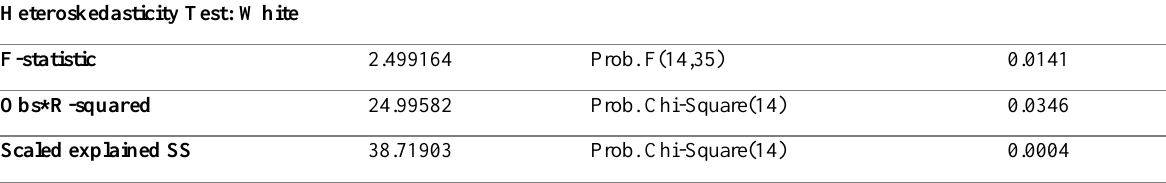
Table 4: Results of the Repair Heteroscedasticity Test with Logarithms Heteroskedasticity Test: